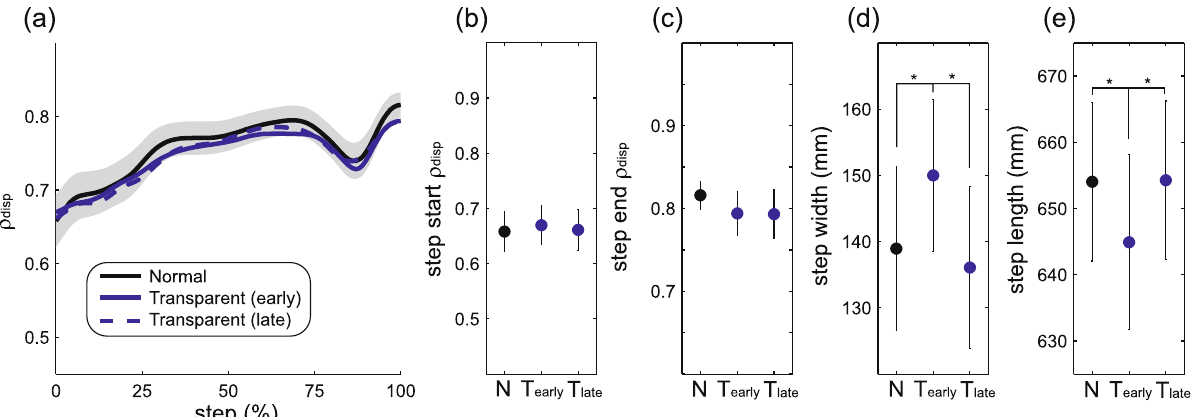
Figure 2. Gait characteristics during initial Normal and Transparent trials. The magnitude of the partial correlation between pelvis displacement and step width (ρ disp ) is illustrated throughout the step (a) for late in the familiarization Normal trial, early in the Transparent trial, and late in the Transparent trial. Here, “early” refers to the first 45 steps, while “late” refers to steps 181–225. Panels ( b – e ) illustrate our four gait outcome measures between these Normal (N), early Transparent (T early ), and late Transparent (T late ) periods. In panel ( a ), the shaded area indicates the 95% confidence interval for the Normal period, while confidence intervals are not shown for the Transparent periods to avoid extensive overlap. In panels ( b – e ), data points indicate means and error bars indicate 95% confidence intervals. Asterisks (*) indicate a significant difference between the indicated